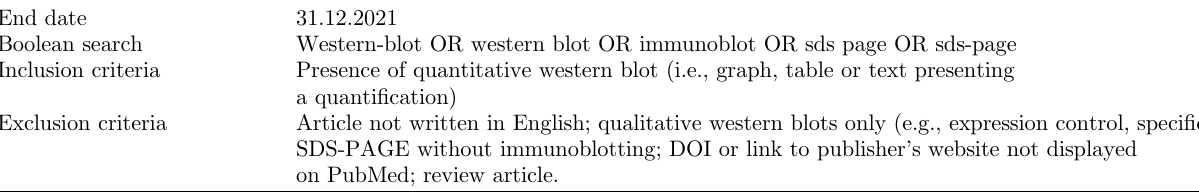
Figure 1. Flow chart of the sampling protocol. Table 1. Eligibility criteria applied to the PubMed search